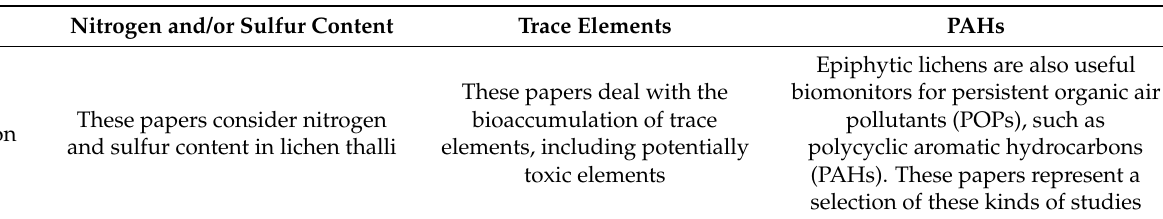
Table 4. Bioaccumulation approach: list of selected